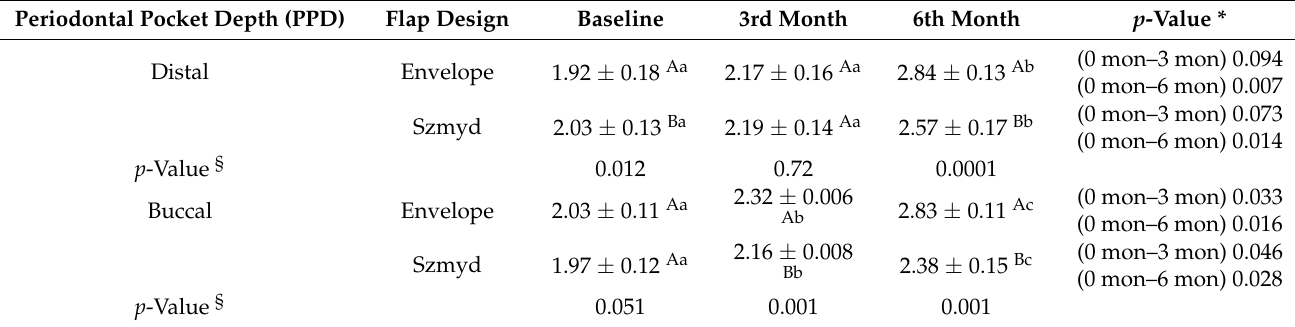
Table 4. Comparison of periodontal pocket depth (mm) around second molars included among study groups.